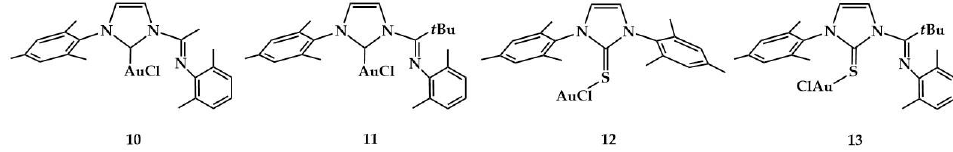
Figure 6. Complexes of Lavoie et al. [19].